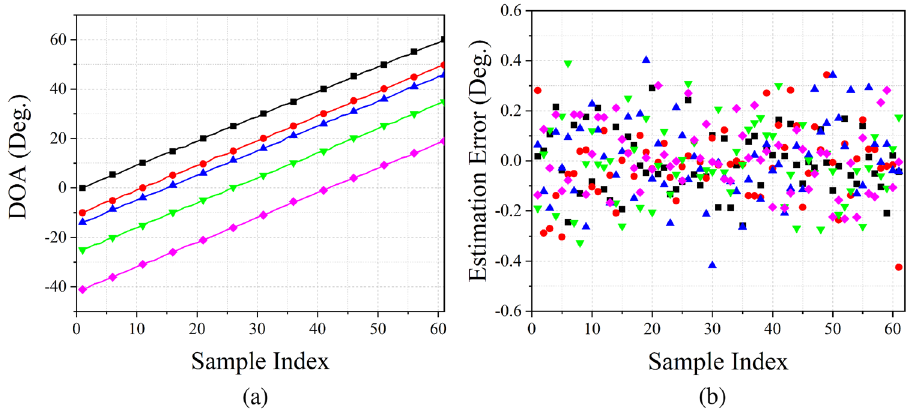
Figure 6. Estimation results of non-integer θ . ( a ) Estimation results of each sample, ( b ) estimation error of each